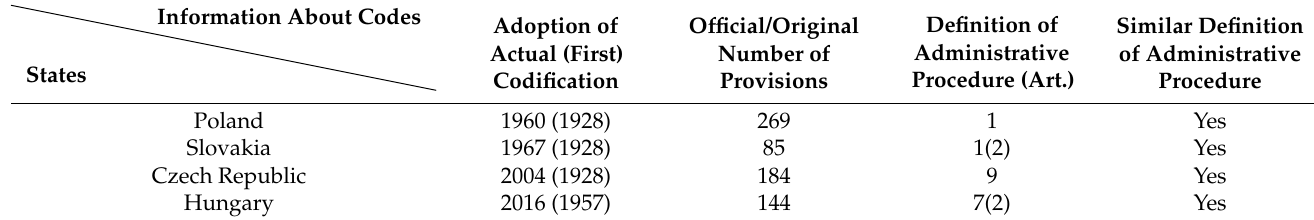
Table 1. Codes of Administrative Procedure of the V4